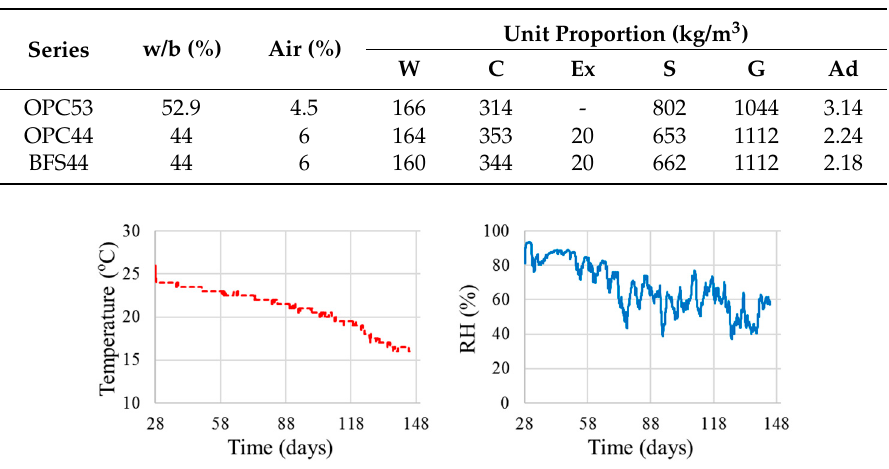
Figure 8. Environmental condition after 28 days of seal-curing.